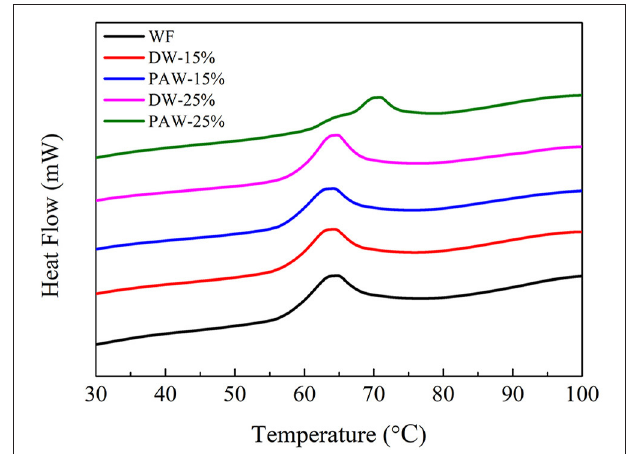
FIGURE 1 | Thermal properties of wheat